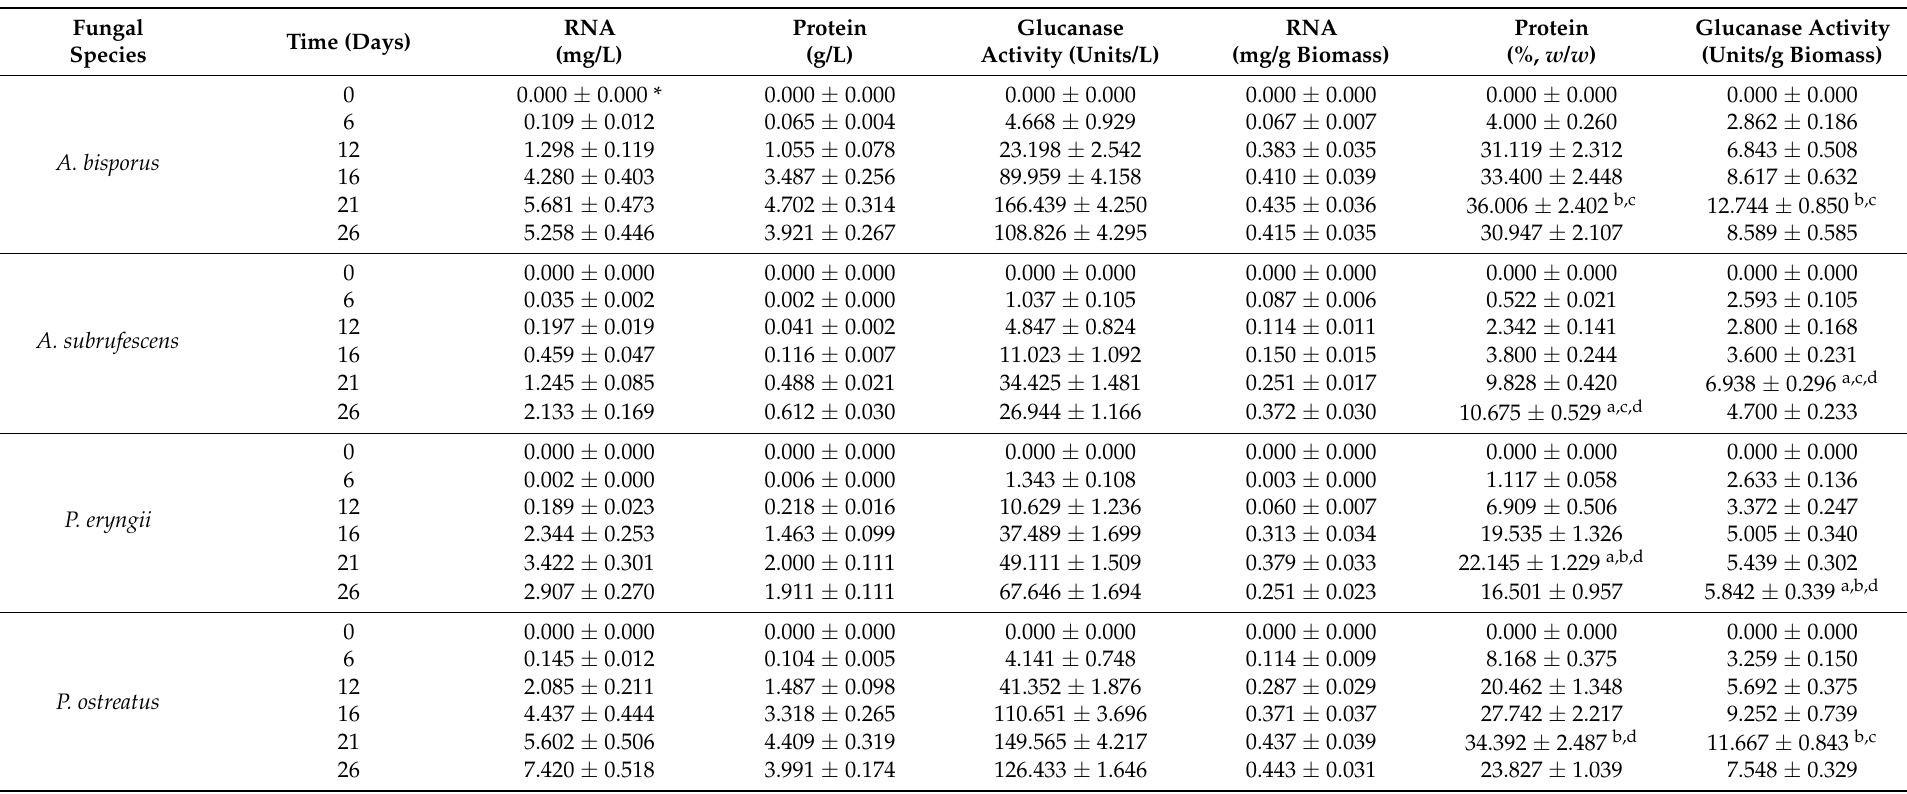
Table 2. Production of RNA, protein and glucanase during cultivation of A. bisporus (a), A. subrufescens (b), P. eryngii (c) and P. ostreatus (d) in agitated (120 ± 5 rpm) liquid cultures of C/N molar ratio 20, at 26 ± 1 ◦